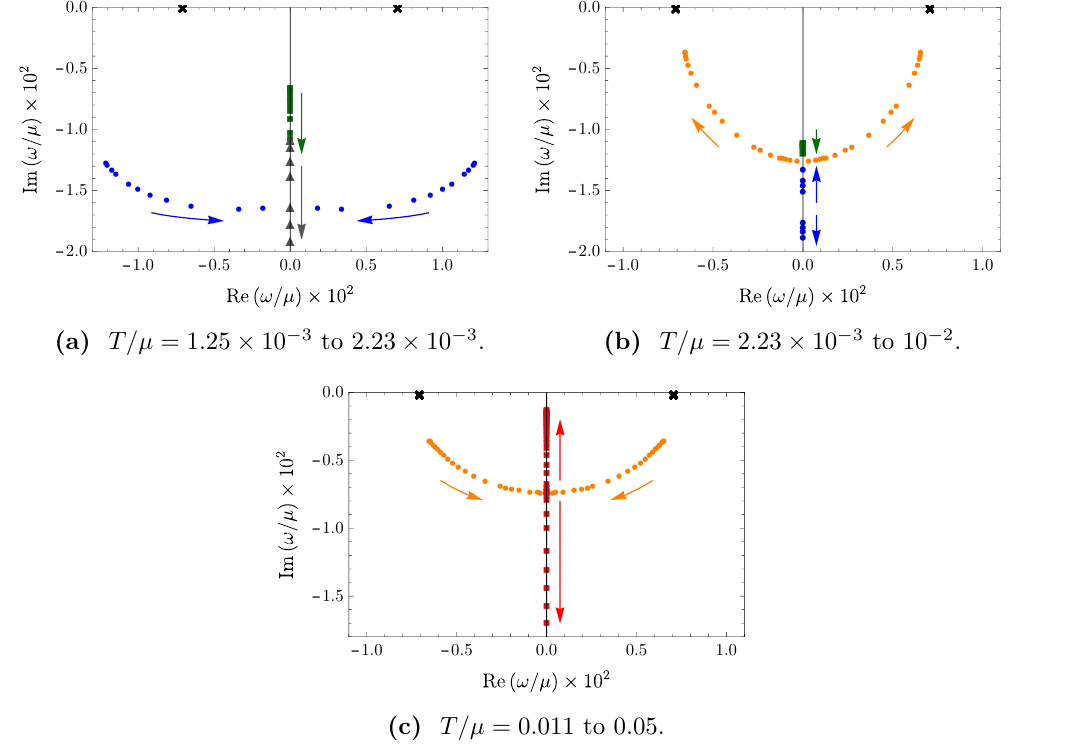
Figure 6. Positions of poles of G J and G tt in the complex !=(cid:22) plane, with (cid:28) = 10 (cid:0) 3 , ~ (cid:11) = 1, k=(cid:22) = 10 (cid:0) 2 , and (a) 1 : 25 (cid:2) 10 (cid:0) 3 (cid:20) T=(cid:22) (cid:20) 2 : 23 (cid:2) 10 (cid:0) 3 , (b) 2 : 23 (cid:2) 10 (cid:0) 3 (cid:20) T=(cid:22) (cid:20) 10 (cid:0) 2 , and (c) 0 : 011 (cid:20) T=(cid:22) (cid:20) 0 : 05. We have enhanced Re ( !=(cid:22) ) and Im ( !=(cid:22) ) by 10 2 for clarity. The arrows indicate the movement of poles as T=(cid:22) increases. The pole motion is considerably more complicated than the previous smaller (cid:28) cases, so for detailed descriptions of the poles and their movement, including the color and shape coding, see the accompanying text. (Animated versions of these (cid:12)gures are available on this paper’s arxiv page.)